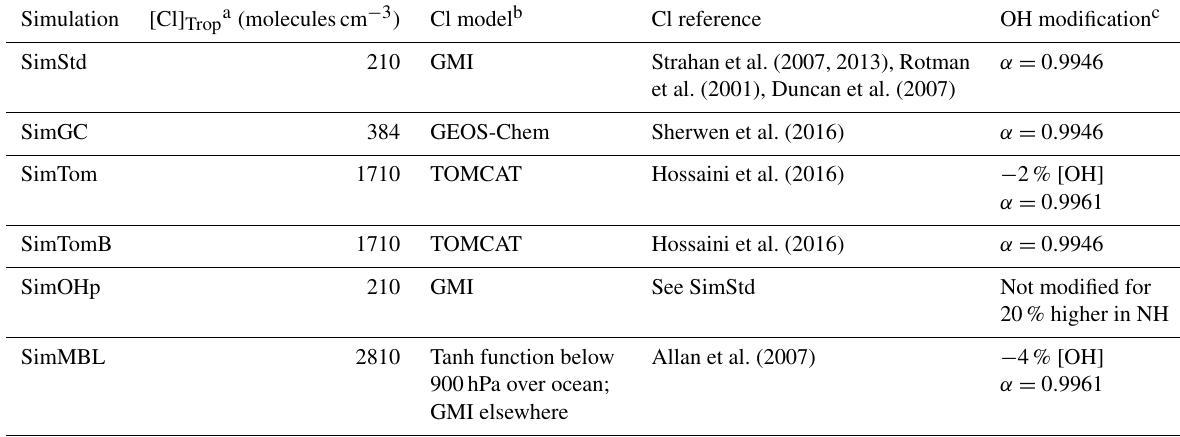
Table 2. Oxidants for the standard and sensitivity simulations.